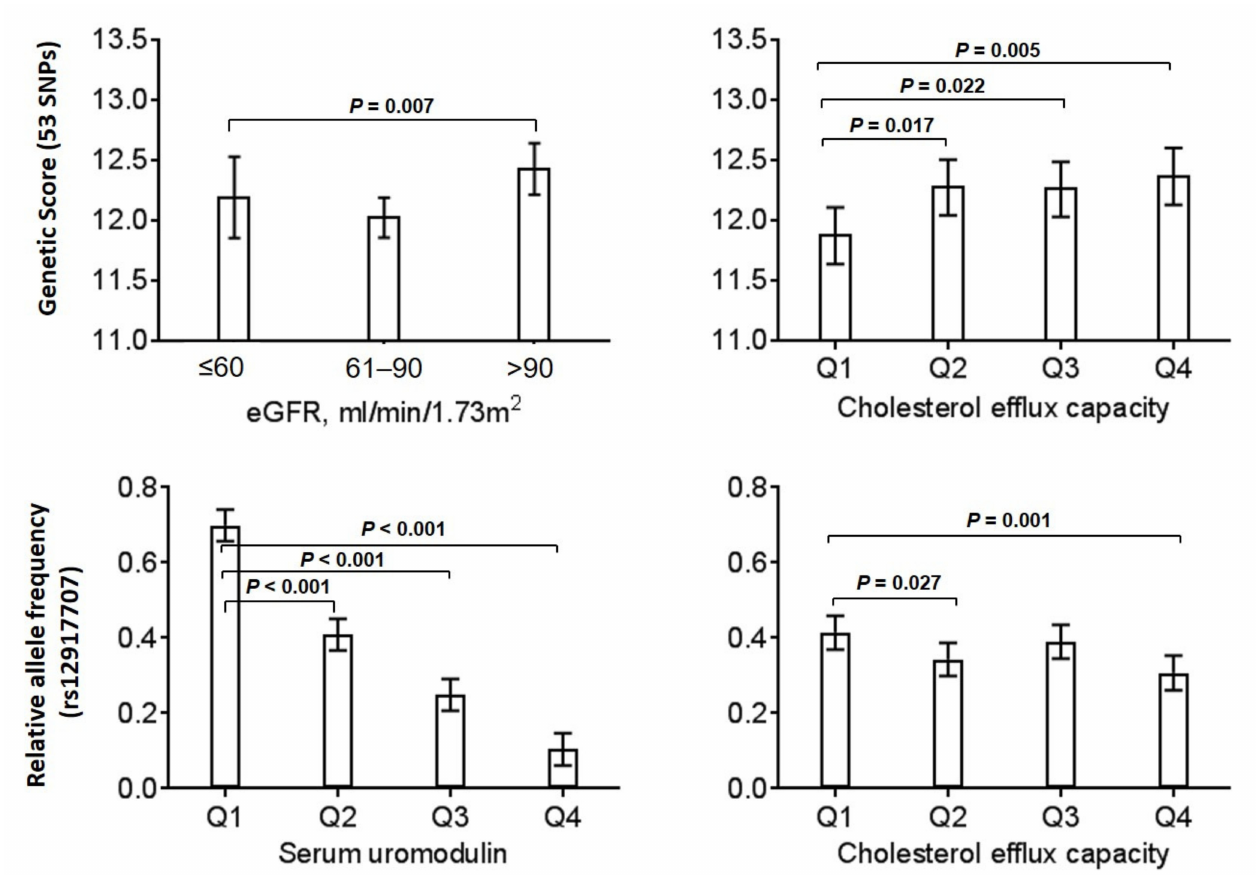
Figure 1. Association of kidney function parameters with corresponding genetic data from SNP analysis. Upper panel: Association of a genetic score of 53 independent SNPs with eGFR ( left ) and with cholesterol efflux capacity ( right ). Lower panel: Association of polymorphism rs12917707 with serum uromodulin ( left ) and with cholesterol efflux capacity ( right ). Diagrams are showing estimated marginal means and 95% confidence intervals obtained in a general linear model, adjusted for age, gender, lipid-lowering therapy, CAD-status, body mass index (BMI), diabetes mellitus, smoking history (never, former, current), hypertension, LDL-C/HDL-C ratio, apolipoprotein AI, and